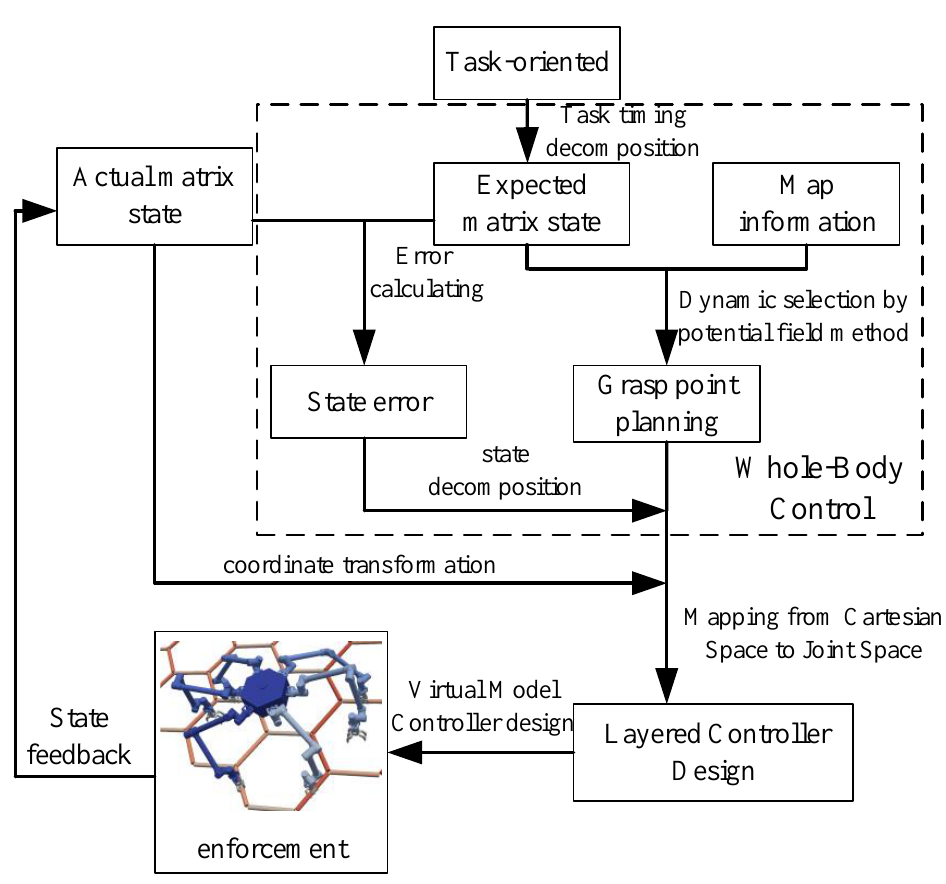
Figure 7. Whole-body controller design and overall control flow.